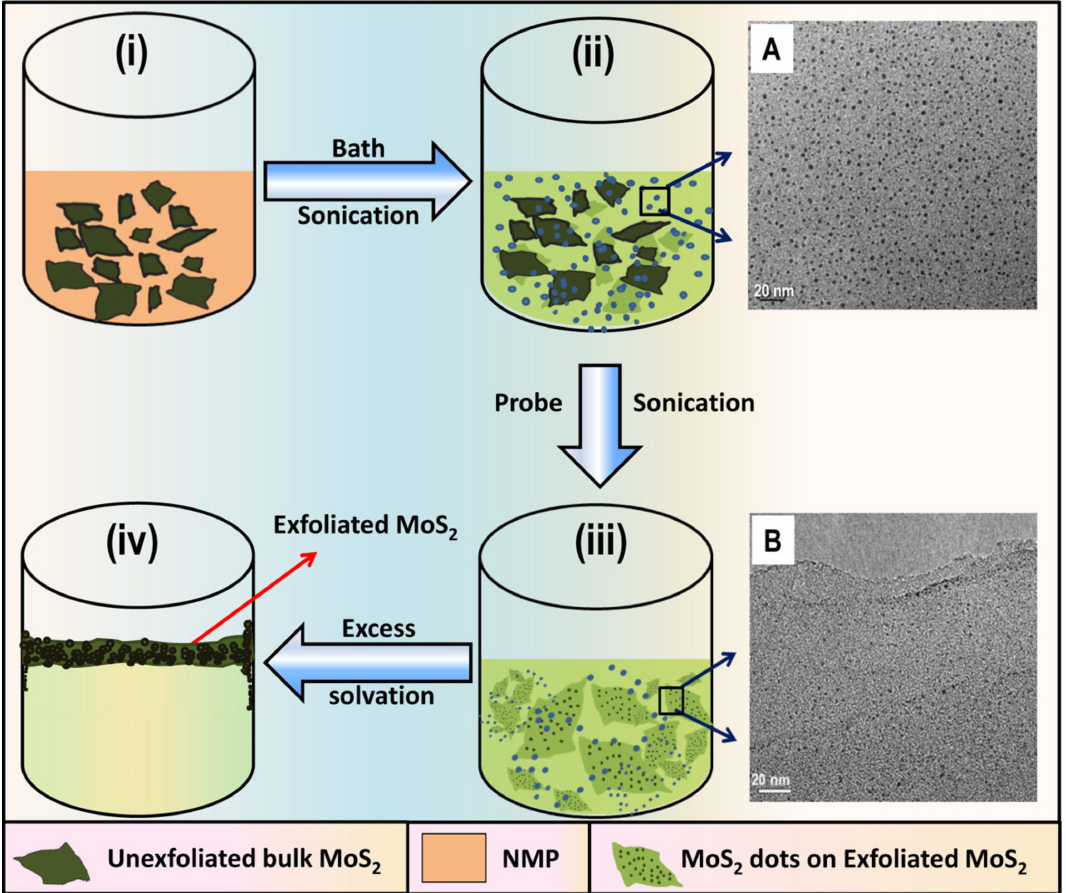
Figure 8. Schematic representation of the synthesis procedure to obtain MoS 2 quantum dots interspersed in MoS 2 nanosheets using a liquid exfoliation approach. ( A ) MoS 2 QDs formed through sonication bath. ( B ) MoS 2 QDs interspersed in the exfoliated MoS 2 nanosheets. [79] Figure reproduced with permission from ACS